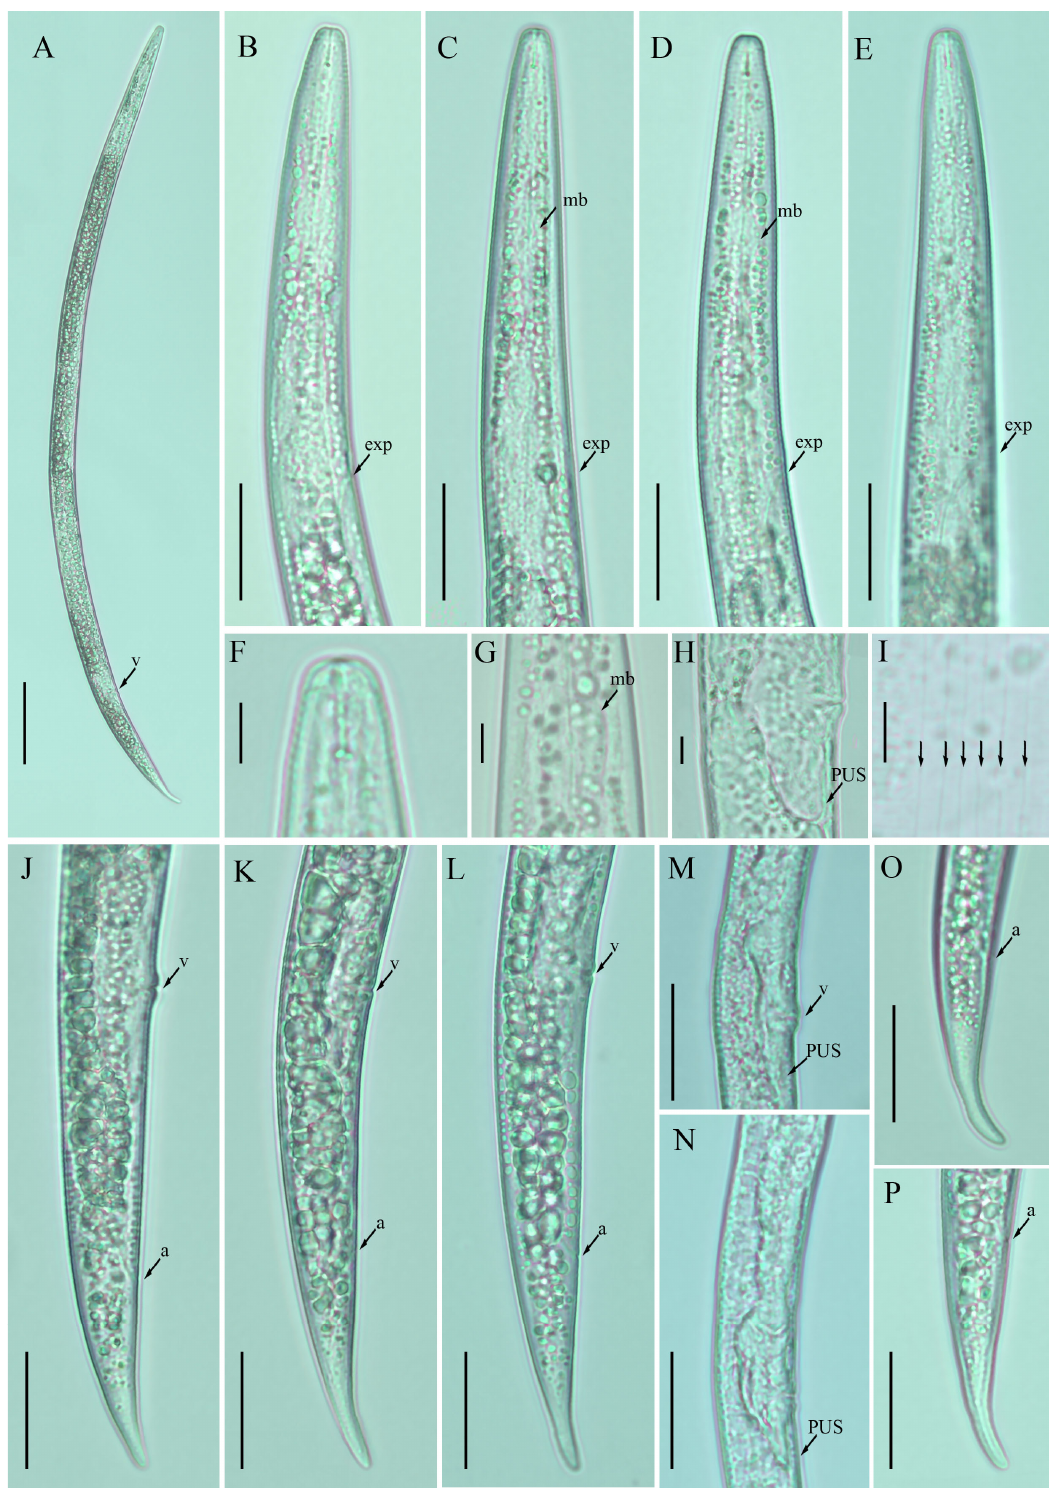
Figure 2. Photomicrographs of female Ditylenchus clarus Thorne and Malek [31] ( A ) Entire body; ( B – E ) pharyngeal regions; ( F ) lip region; ( G ) median bulb; ( H , M , N ) vulval regions; ( I ) lateral field lines; ( J – L ) posterior body to tail terminus; ( O , P ) tail regions. Scale bars: ( A ) 50 µm; ( B – E , J – O ) 20 µm; ( F – I ) 5 µm. Arrows: (a) anus; (exp) secretory–excretory pore; (mb) median bulb; (PUS) postvulval uterine sac; (v) vulva.